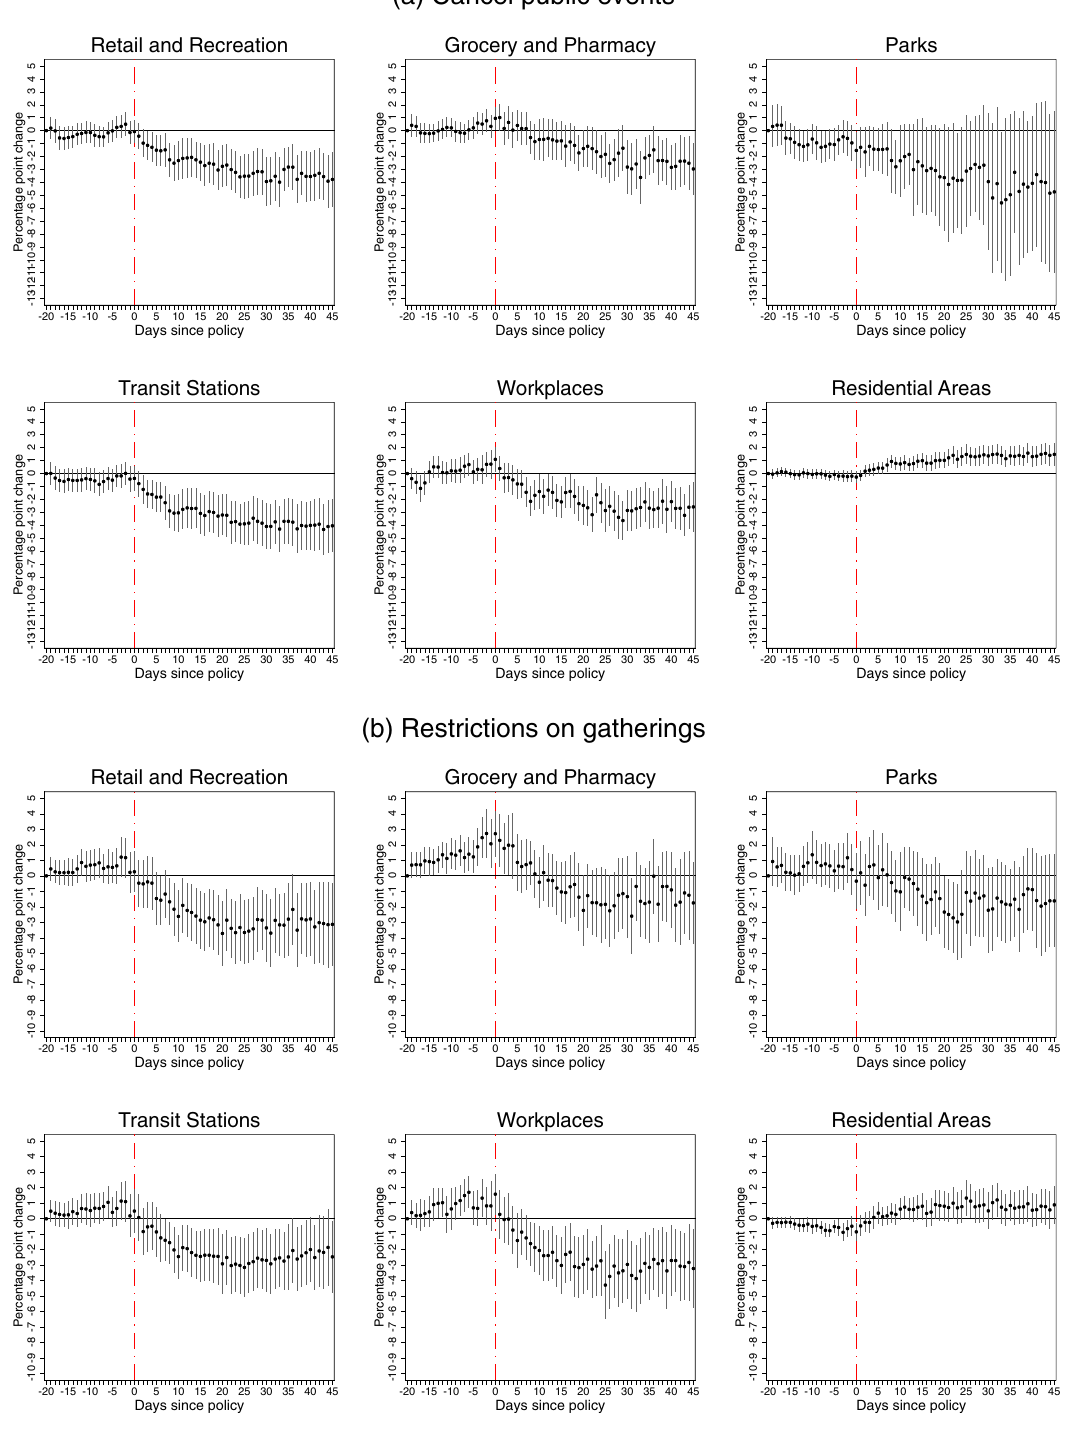
Figure 3. Effects of public events cancellations (panel a ) and restrictions on gatherings (panel b ) on Google mobility